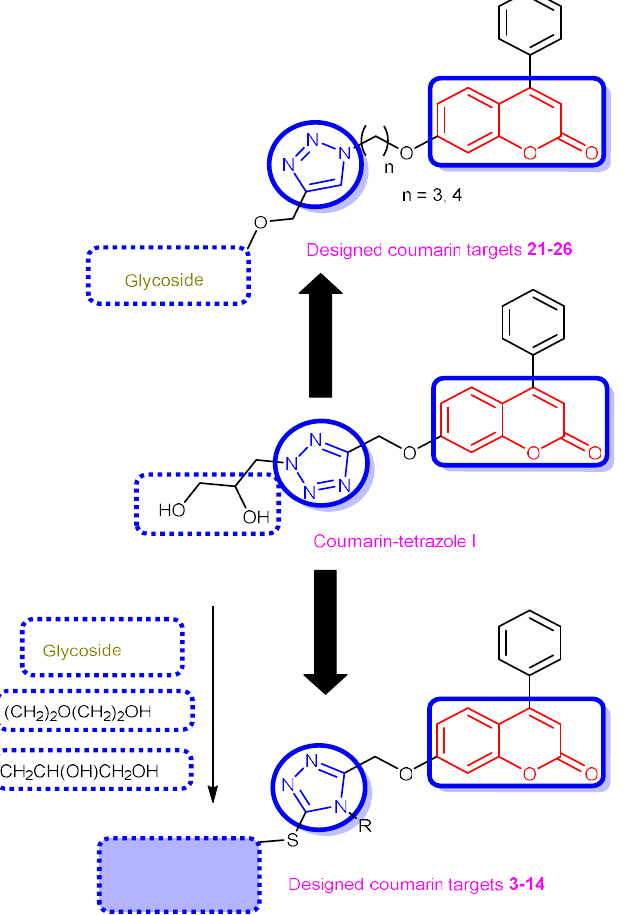
Figure 2. Design of new coumarin-triazole hybrids expected to possess potent antiproliferative activity through inhibition of EGFR, VEGFR-2 and CDK-2 kinases.